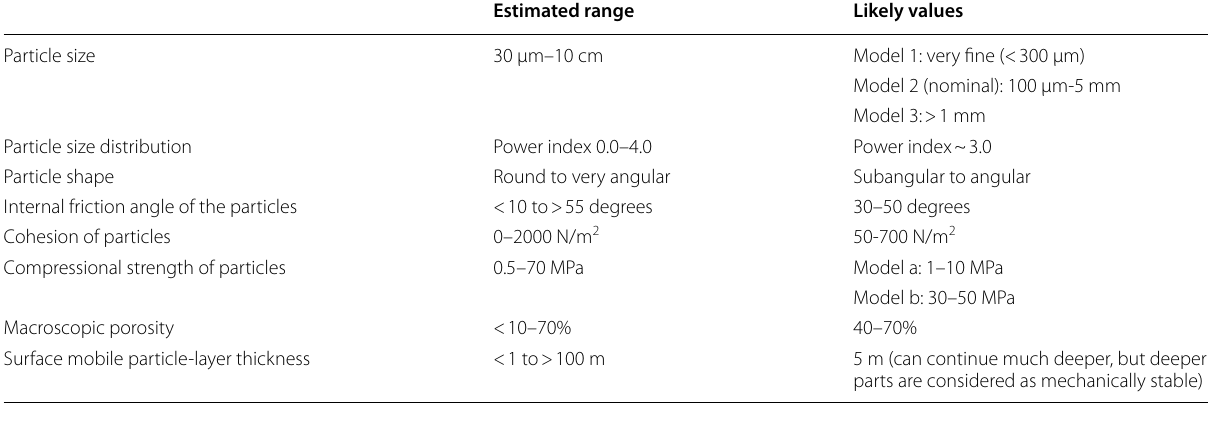
Table 2 Reference model properties of the surface regolith of Phobos